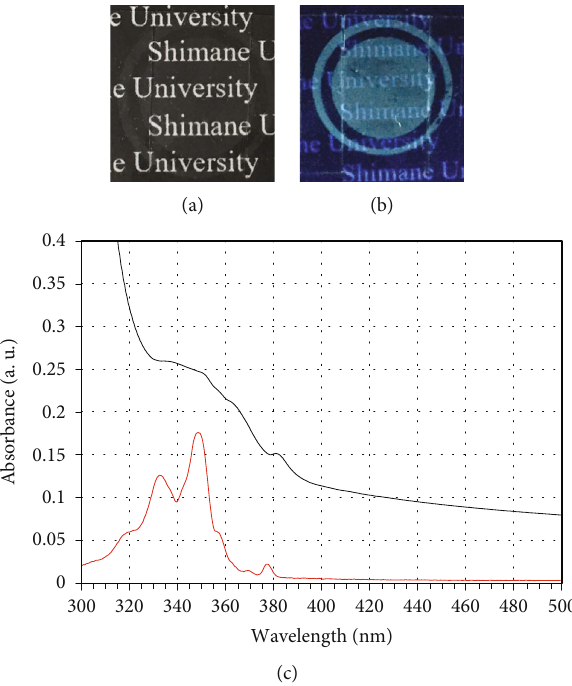
Figure 6: Photograph of the Pyr − /LDH fi lm under (a) room light, (b) UV light irradiation (365nm), and (c) UV-Vis absorption spectra of the Pyr − /LDH fi lm (black line) and Pyr - aqueous solution ( 1 : 0 × 10 − 5 mol/L, red line).